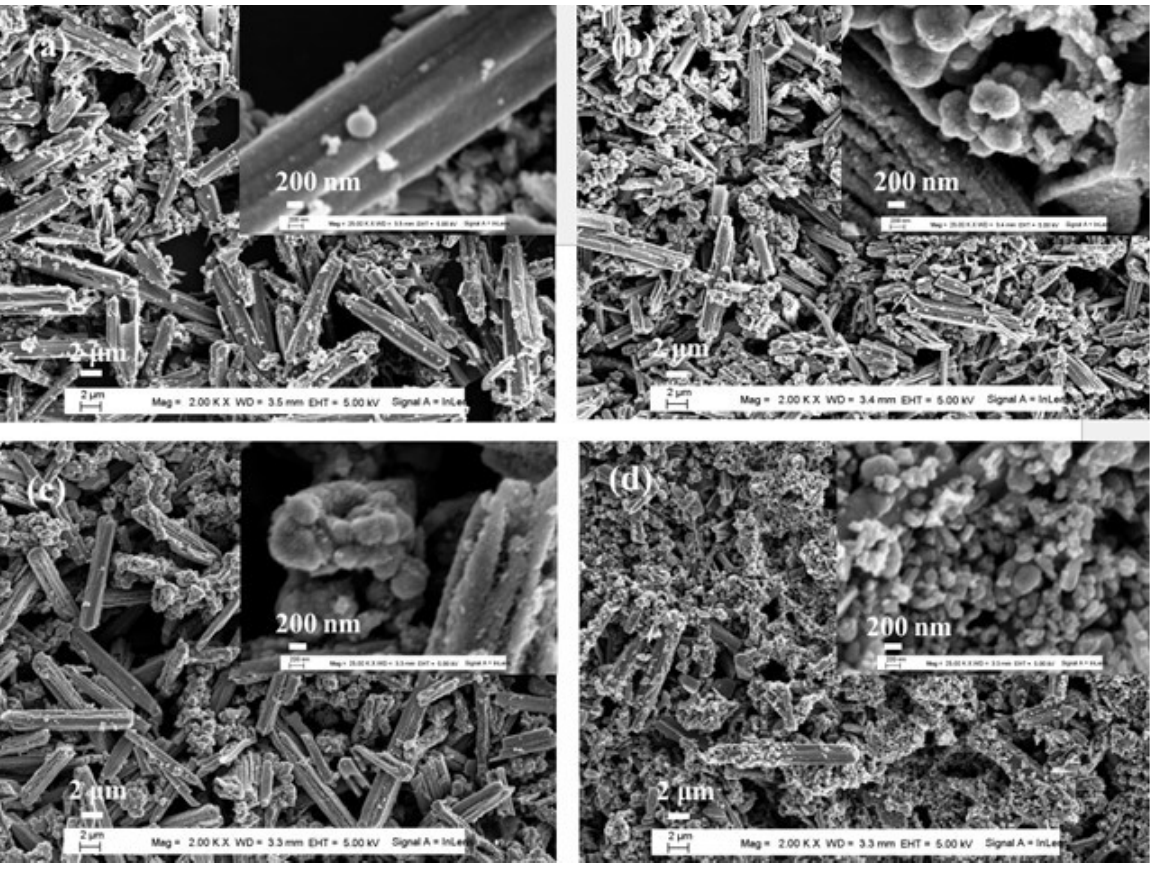
Figure 2. FEG-SEM images of prepared TiO 2 powders at various synthesis temperatures: ( a ) 170 °C; ( b ) 190 °C; ( c ) 210 °C; and ( d ) 230 °C, inserts are the corresponding high magnification.